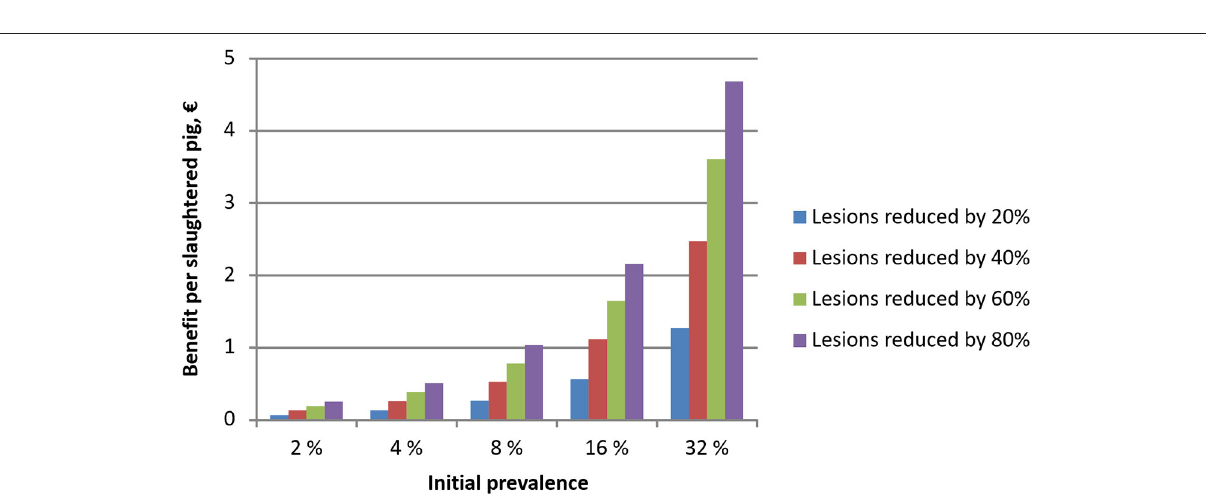
FIGURE 3 | Simulated financial benefits when tail biting lesions in fattening pigs are reduced by 20, 40, 60, or 80% from the initial prevalence level (level before applying an intervention) and the initial prevalence is 2, 4, 8, 16, or 32%. The benefits do not include the cost of an intervention